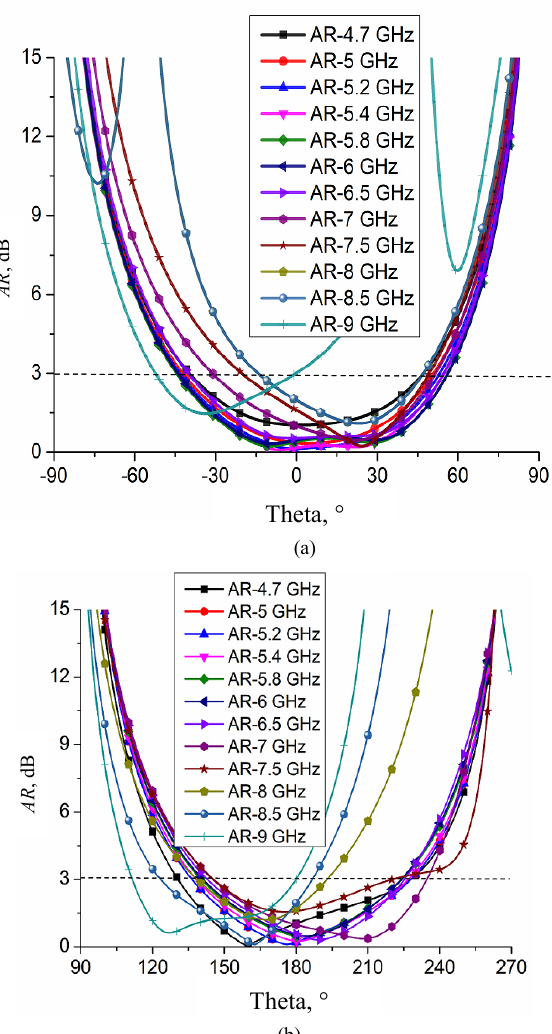
Fig. 14. AR at ɸ = 0°: (a) LHCP in the xz -plane and (b) RHCP in the yz -plane.